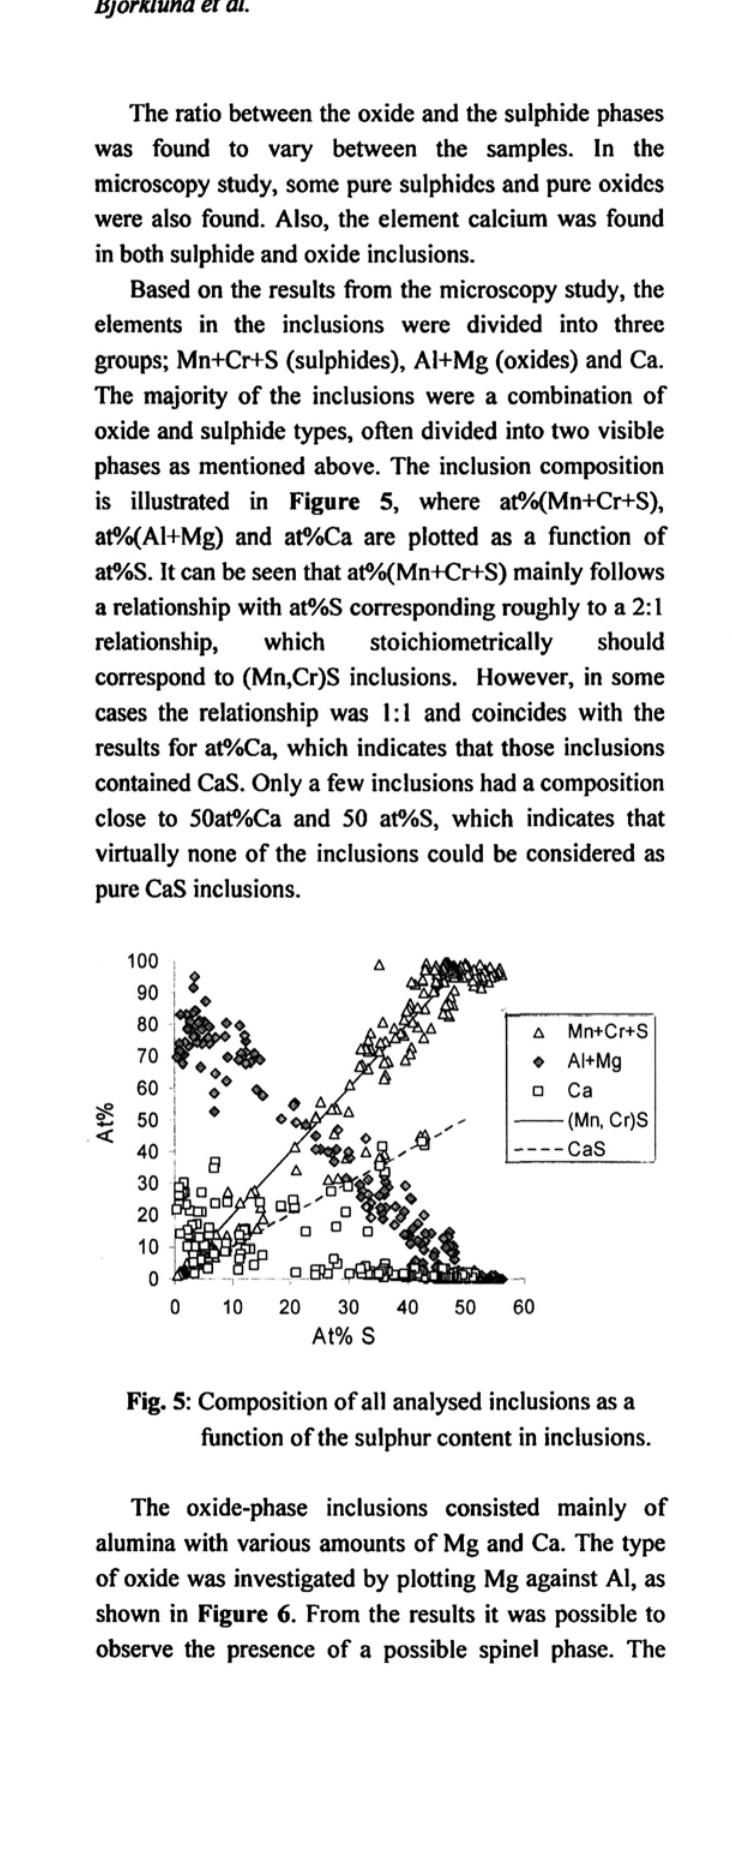
Fig. 6: Ratio between Al and Mg in inclusions analysed before (BV) and during vacuum treatment